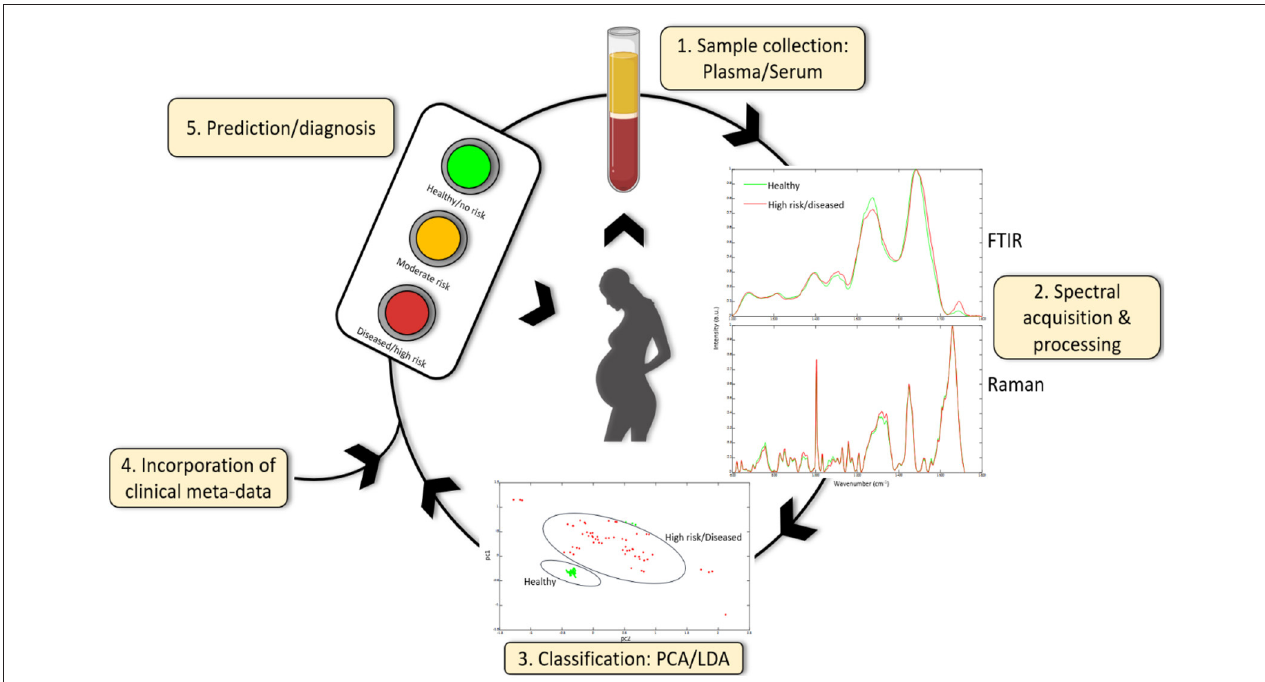
FIGURE 3 | Serum or plasma obtained from pregnant women can be used to acquire spectra using FTIR or Raman spectroscopy. Spectral data can be further classified using chemometric methods (and machine learning) including principle component analysis (PCA) and linear discriminant analysis (LDA) and can be combined with other clinical meta-data to give a diagnosis or prediction of disease development. Additionally, spectral data can identify novel candidate biomarkers which may be useful in future diagnostic test